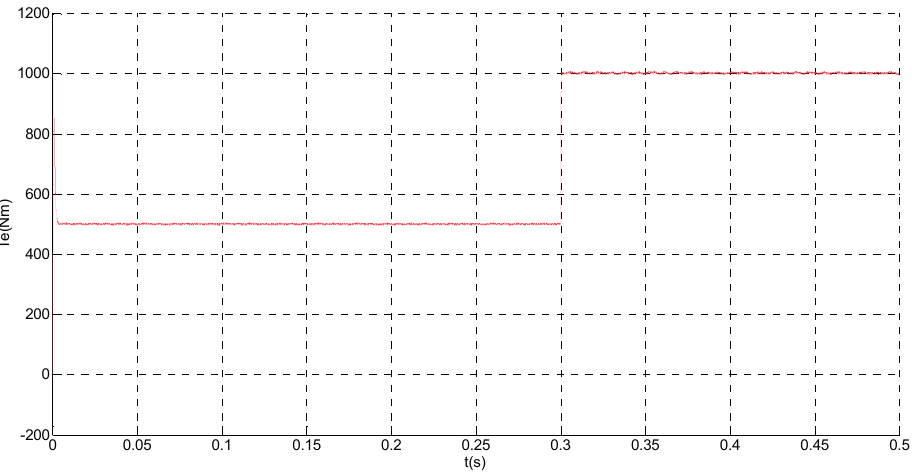
Figure 2. Simulation results of the observation of extended flux linkage.